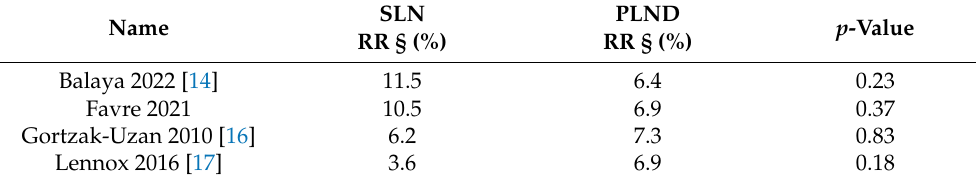
Table 4. Recurrence rate.